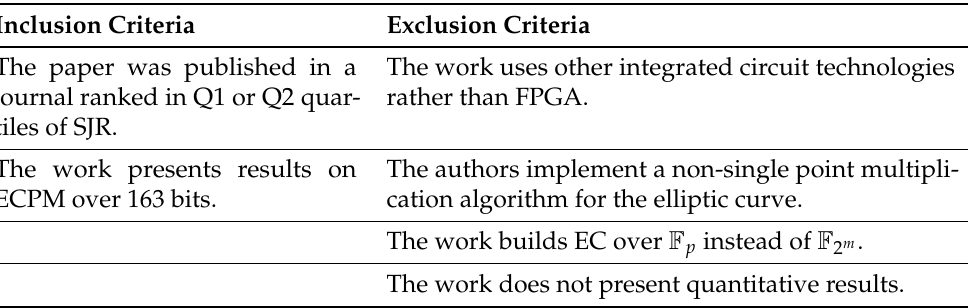
Table 3. Inclusion and Exclusion